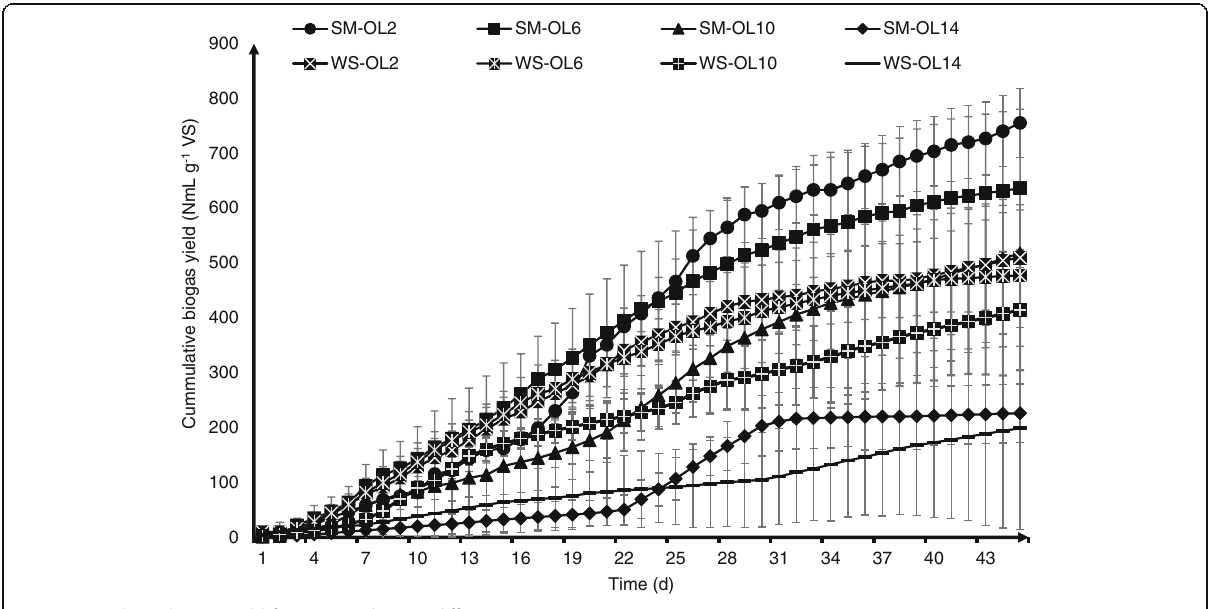
Fig. 4 Cumulative biogas yield from SM and WS at different OLs